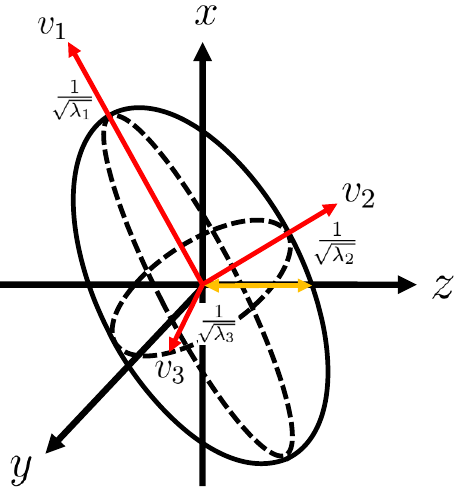
Fig. 2. Force ellipsoid representation.